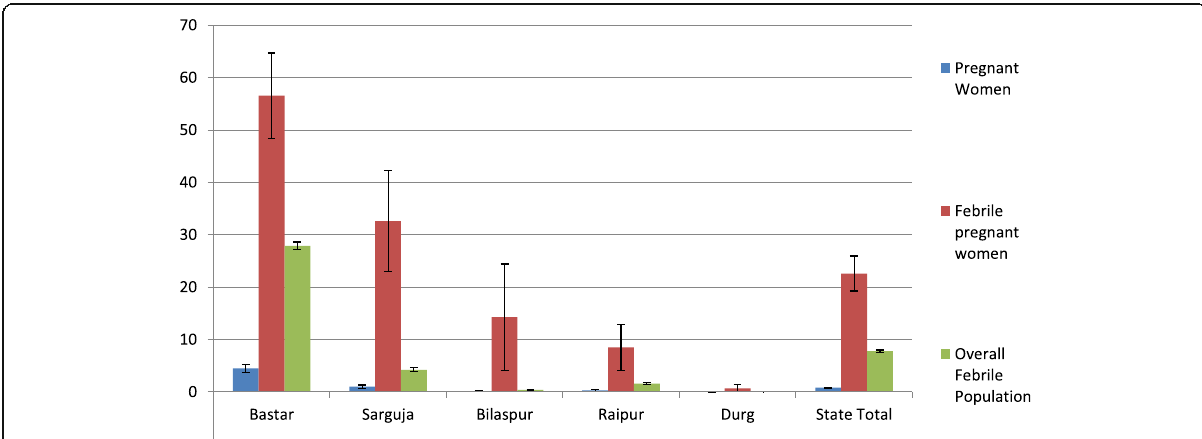
Fig. 4 Division-wise comparison of malaria positivity in pregnant women versus overall febrile population in rural Chhattisgarh November – December 2019 (% malaria positive with 95% CI)